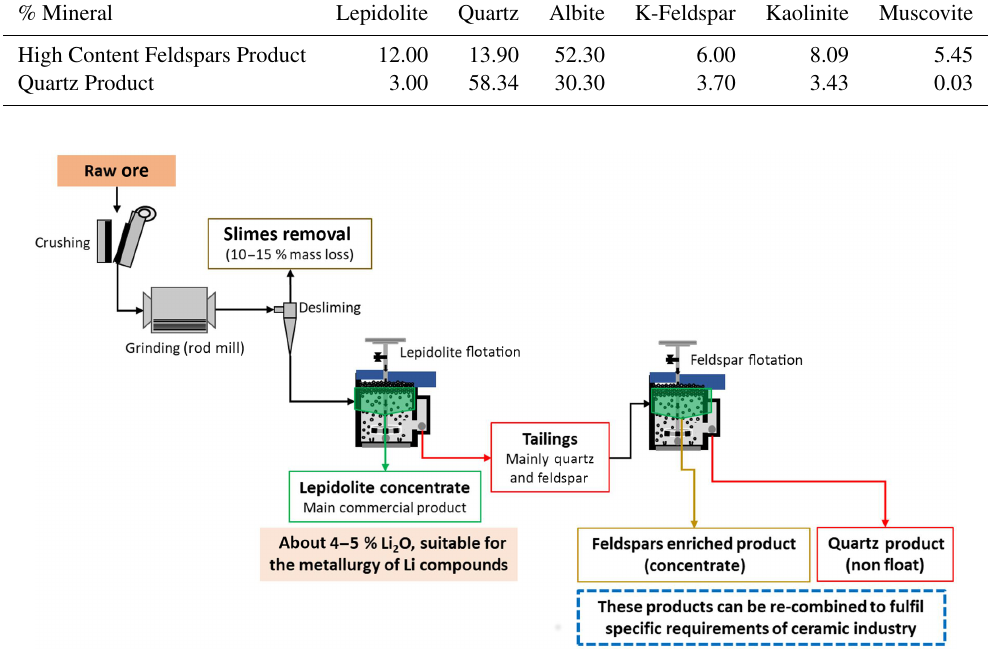
Figure 2. Flowsheet proposal for Alvarrões-Gonçalo ore